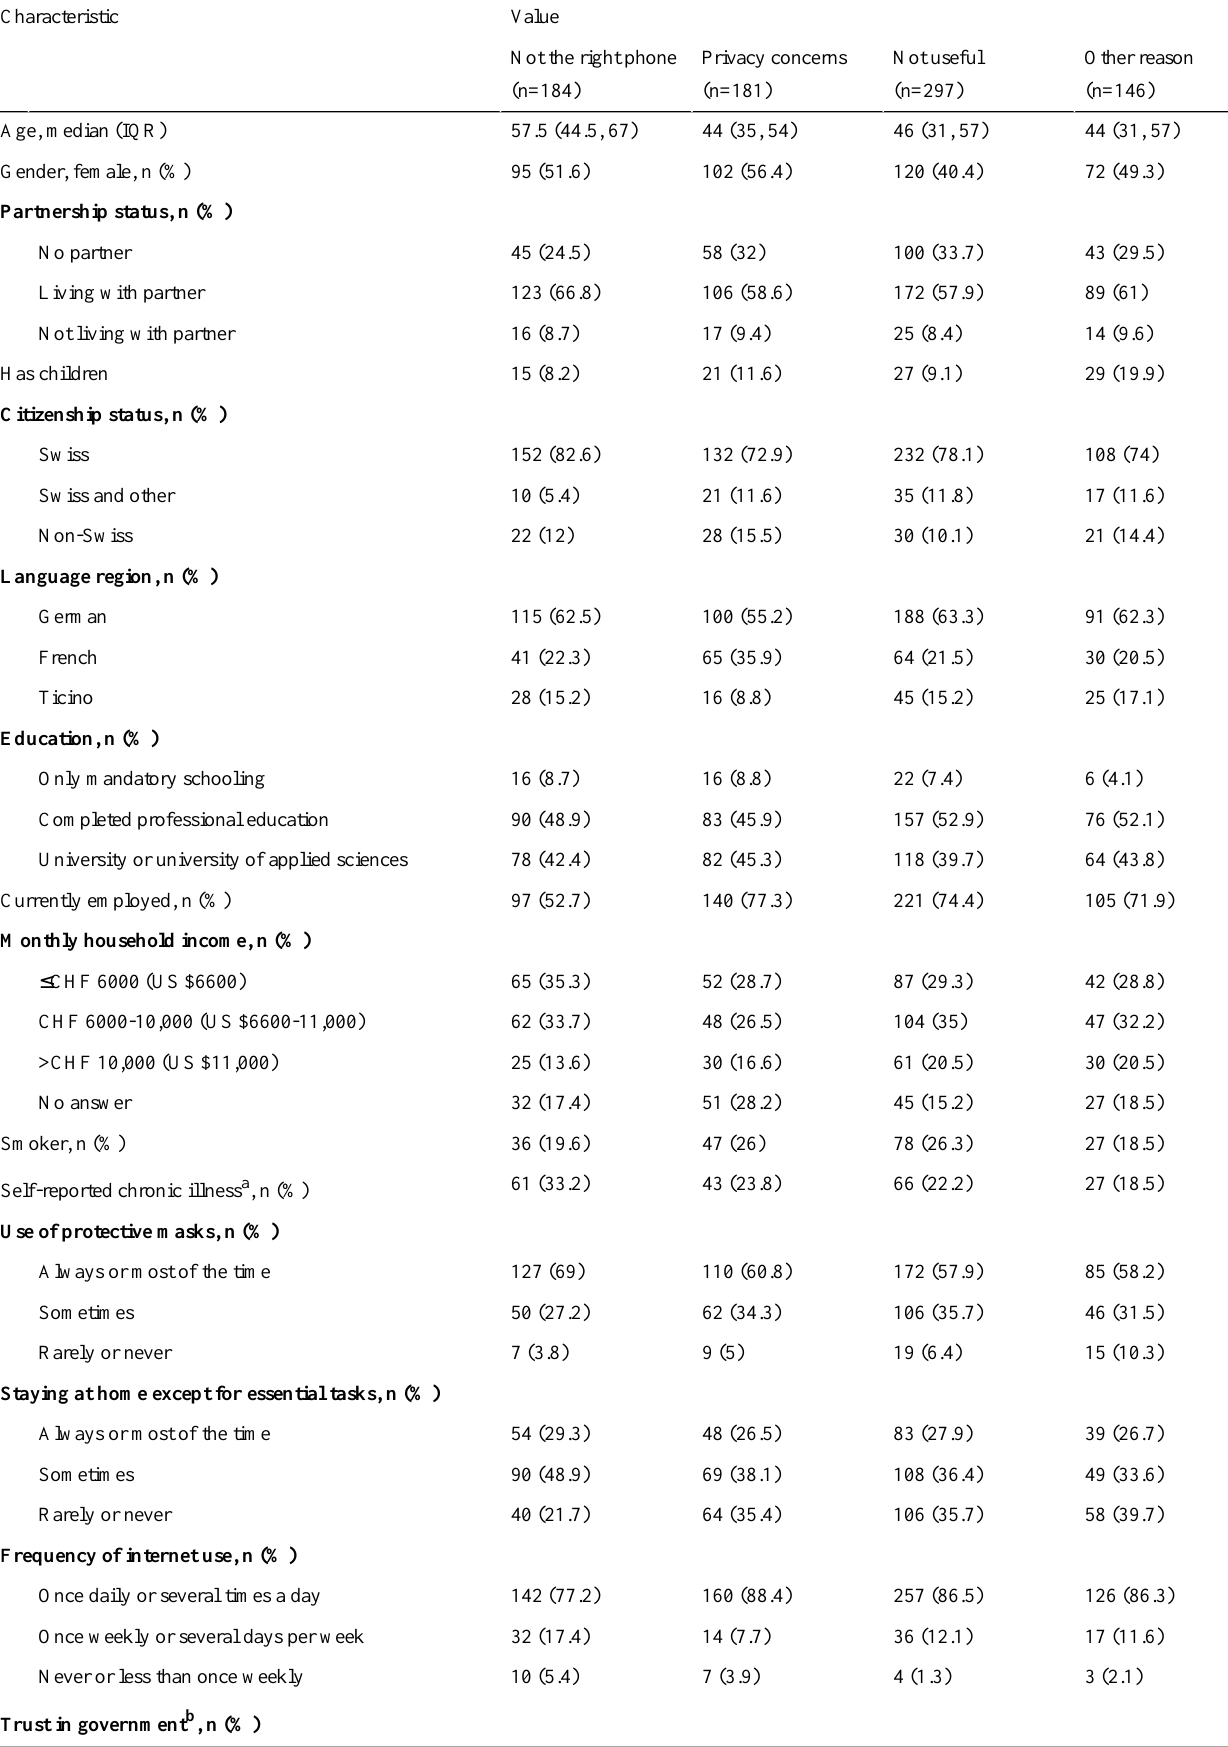
Table 4. Sociodemographic characteristics of SwissCovid app nonusers, stratified by the reason for app nonuse (3 most frequent reasons and “other”).